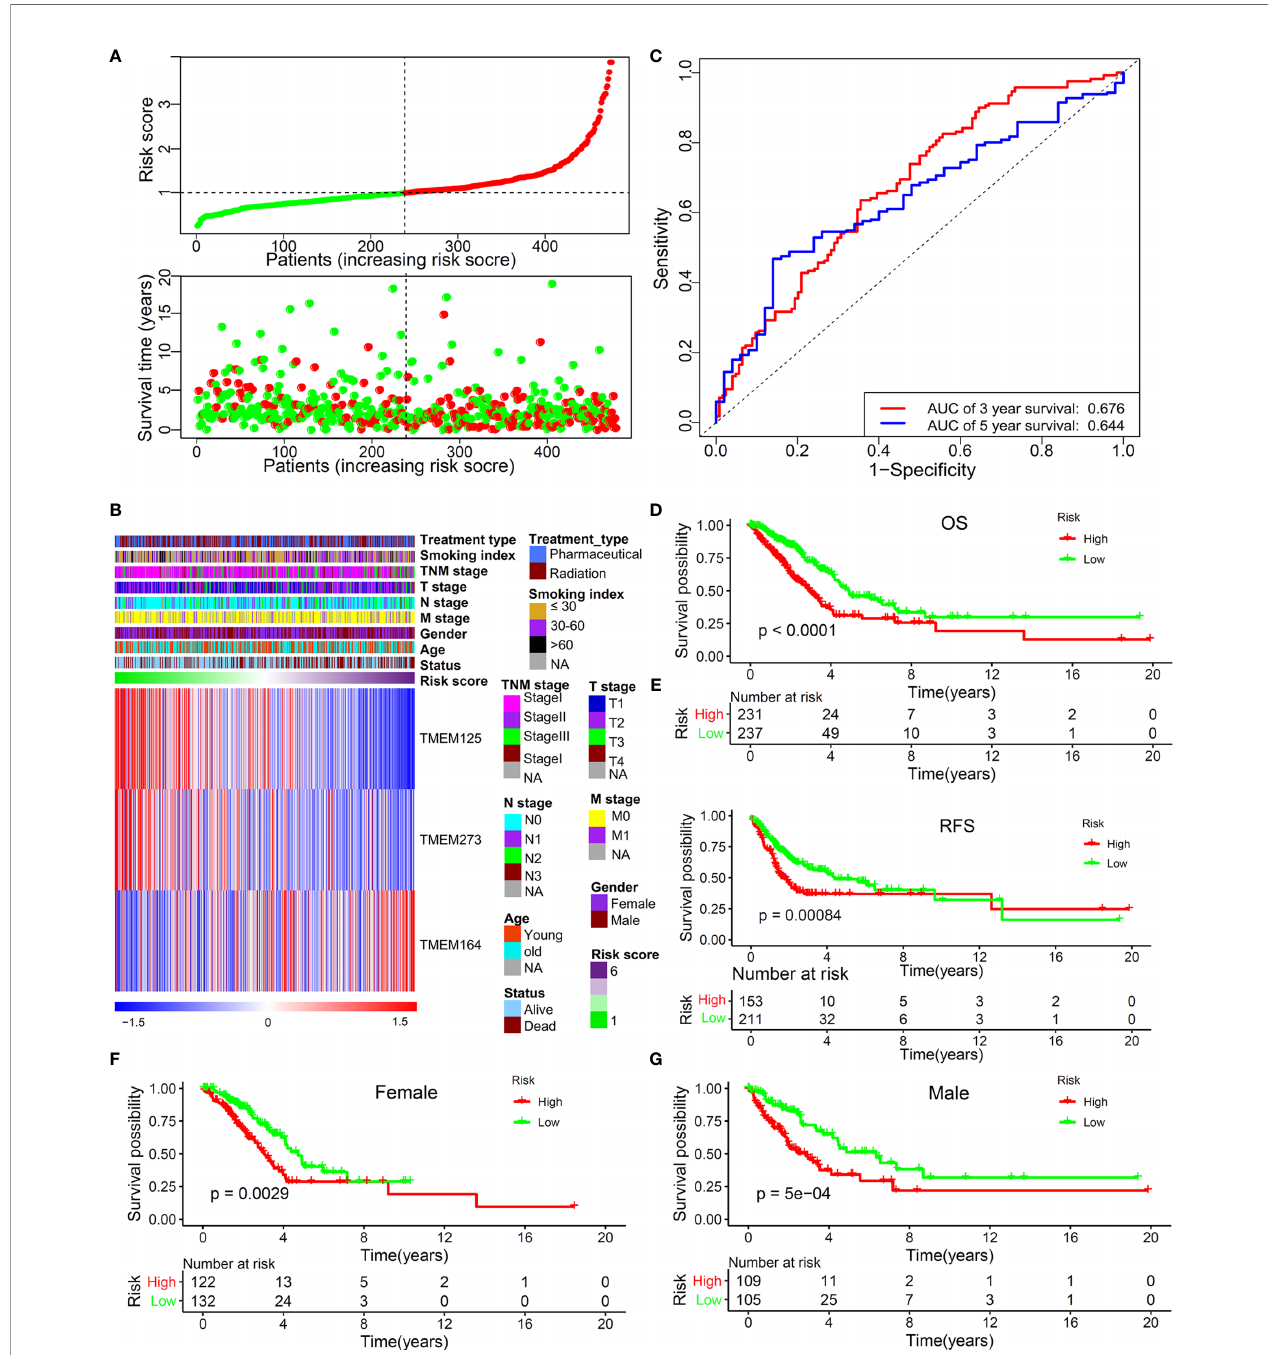
FIGURE 2 | The predictive value of this TMEM-based signature in TCGA training set. (A) The distribution of survival time and risk score. (B) The 3 independent prognostic genes ’ expression panel based on constructed risk score and clinical features. (C) The predictive value of this risk model for the 3-year (AUC, 0.676) and 5-year (AUC, 0.644) OS of patients with LUAD. (D) OS analysis for the two risk patterns based on 477 patients with LUAD. (E) RFS analysis for the two risk patterns based on training set. OS analysis for the two risk patterns in female (F) and male patients (G)